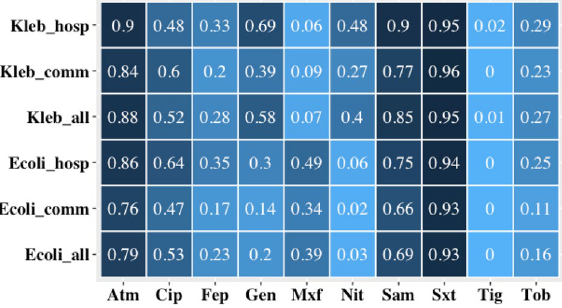
Figure 1. Heatmap showing the proportion of resistant isolates among ESCrE for ten of the seventeen antibiotics tested. Increasing color intensity denotes increasing proportion of resistant isolates. Seven are not shown because all isolates were fully resistant to ceftriaxone, ampicillin, and cefazolin and none had intermediate or complete resistance to amikacin, ertapenem, imipenem and meropenem. Heatmap includes 1345 E. coli (hospital = 492, community = 863) and 442 Klebsiella oxytoca and K. pneumoniae pooled (hospital = 280 hospital, community = 162). Antibiotics: aztreonam (Atm), ciprofloxacin (Cip), cefepime